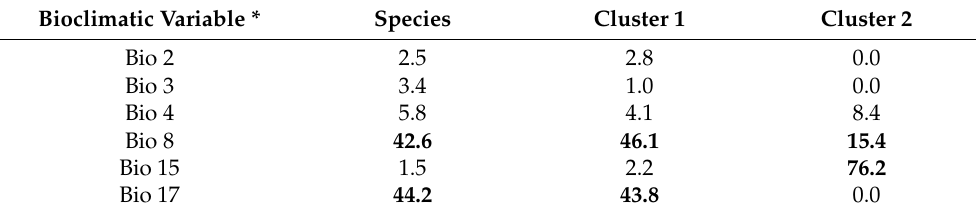
Table 5. Percent contribution of each bioclimatic variable to the fit of the ecological niches modeled for Ilex guayusa at the species level and for each of its genetic clusters. The two highest contributing variables for each model are highlighted in bold.